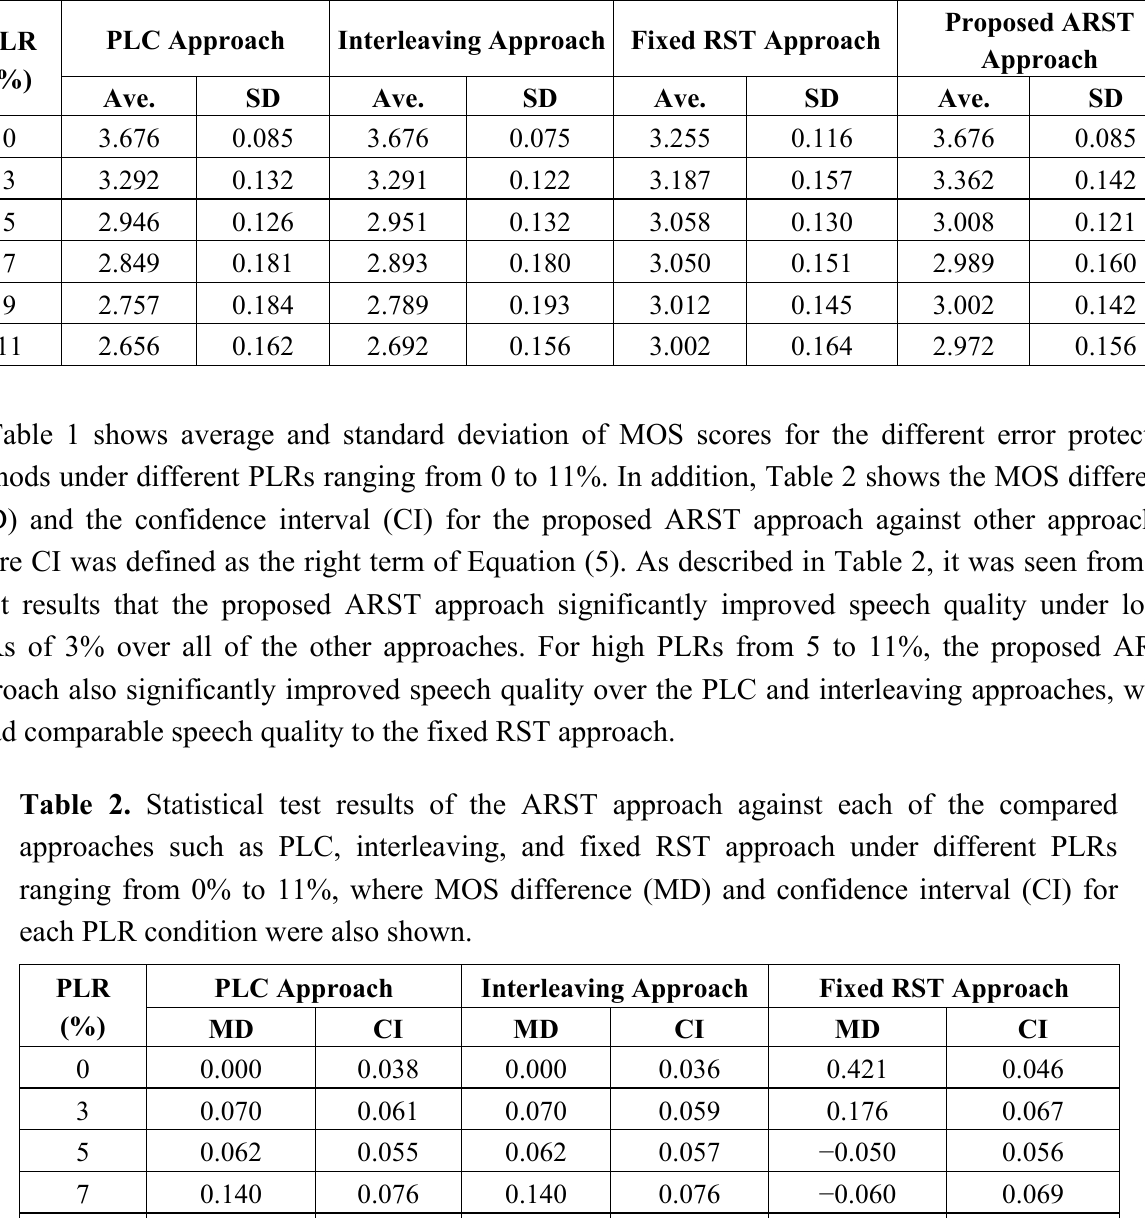
Table 1. Average (Ave.) and standard deviation (SD) of MOS scores measured by PESQ for the different error protection methods, under PLRs ranging from 0% to 11%.